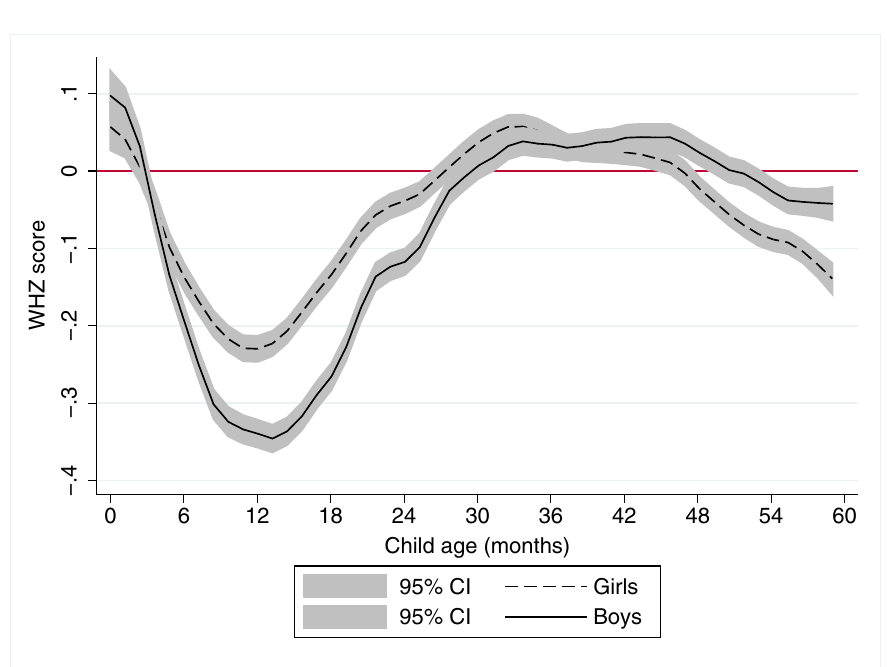
Fig 2. A local polynomial regression plot of weight-for-height z score against child age for 699,421 children aged 0–59 months in 57 countries. Notes: The graph is based on local polynomial smoothing estimates of WHZ scores against child age for 699,421 children from 125 Demographic Health Surveys for 57 countries. 95% confidence intervals (CI) are reported in grey